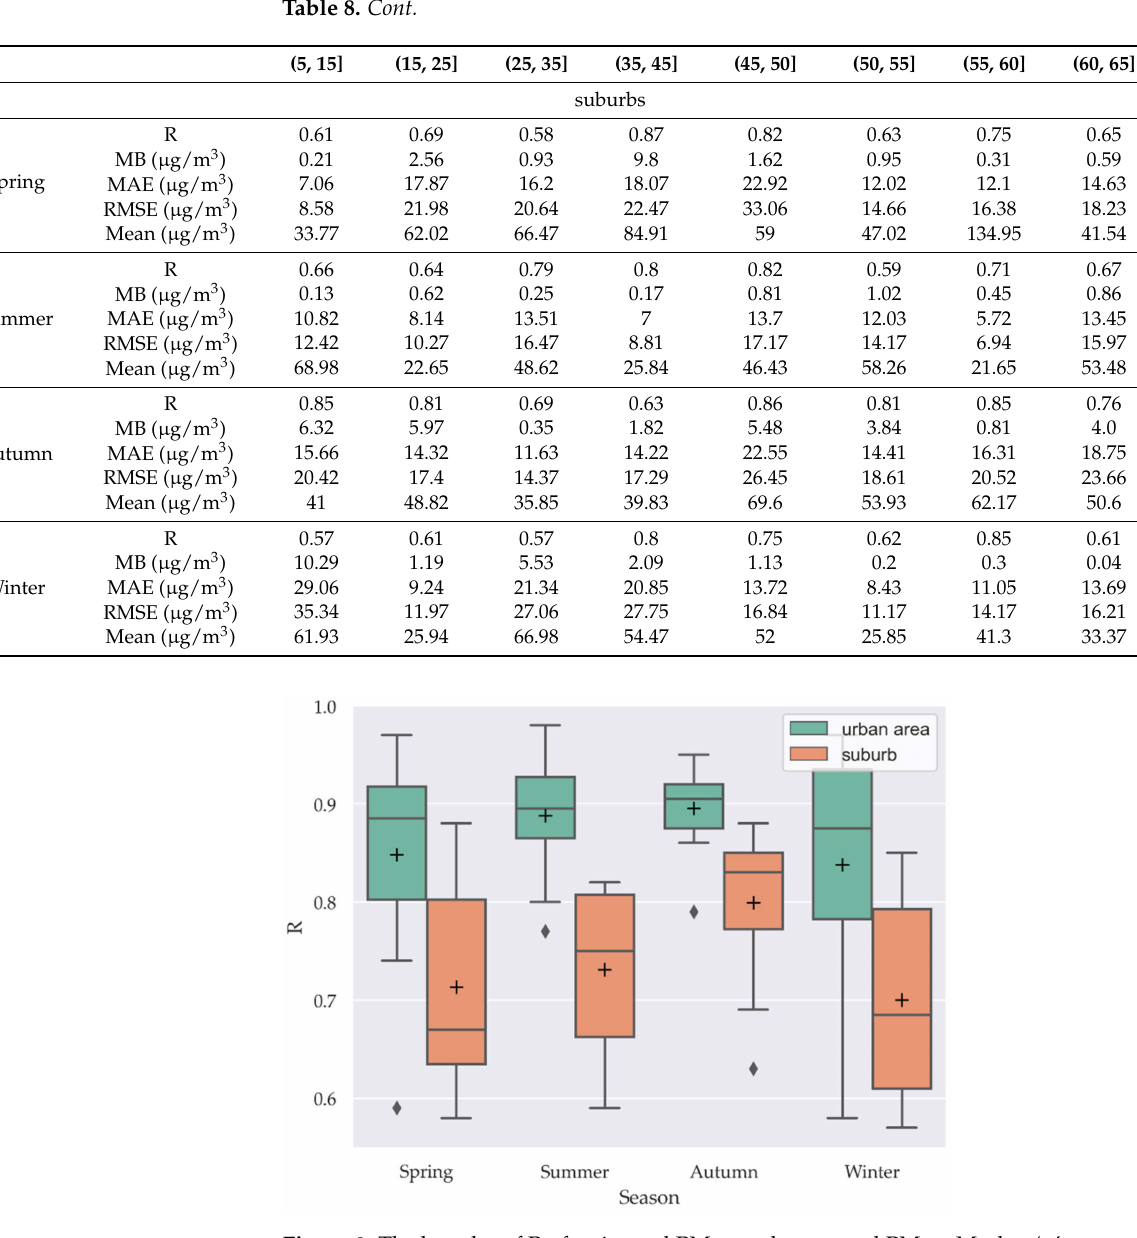
Figure 8. The boxplot of R of estimated PM 2.5 and measured PM 2.5 . Marker ‘+’ represents the mean of R, and diamond ‘ (cid:117) ’ represents the outlier below the lower boundary